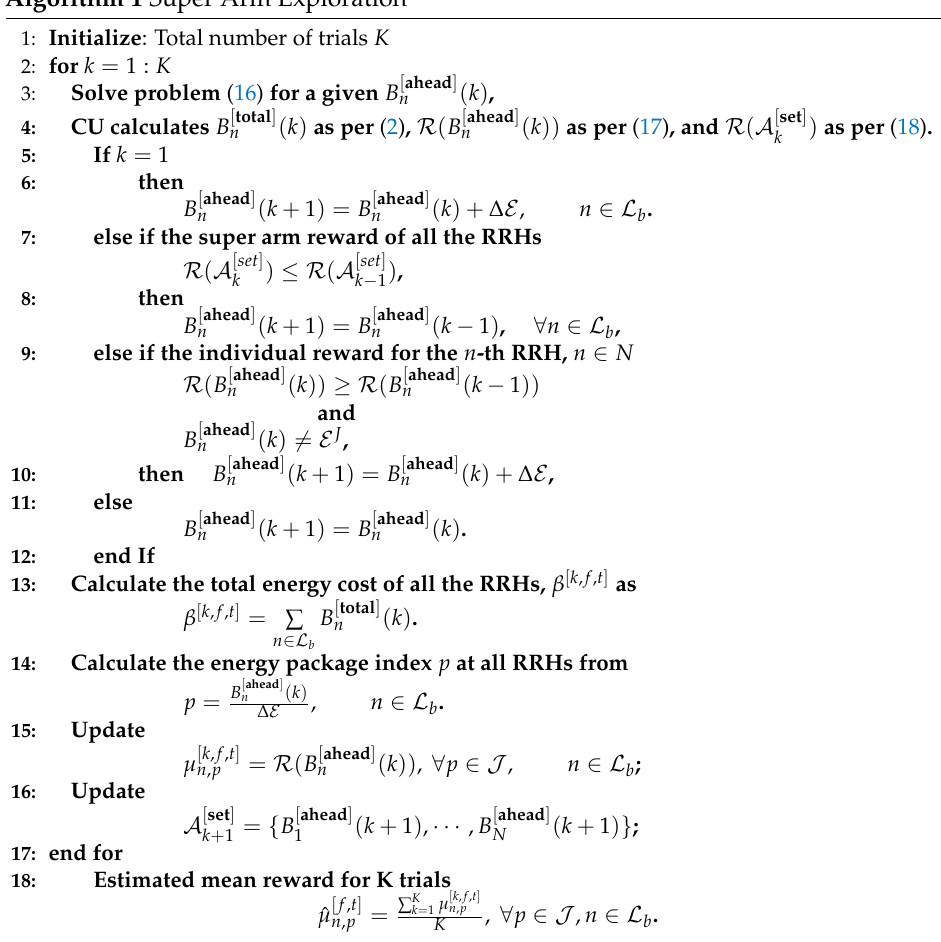
Figure 2. Proposed predictive energy trading strategy in a Cloud-RAN. Algorithm 1 Super Arm